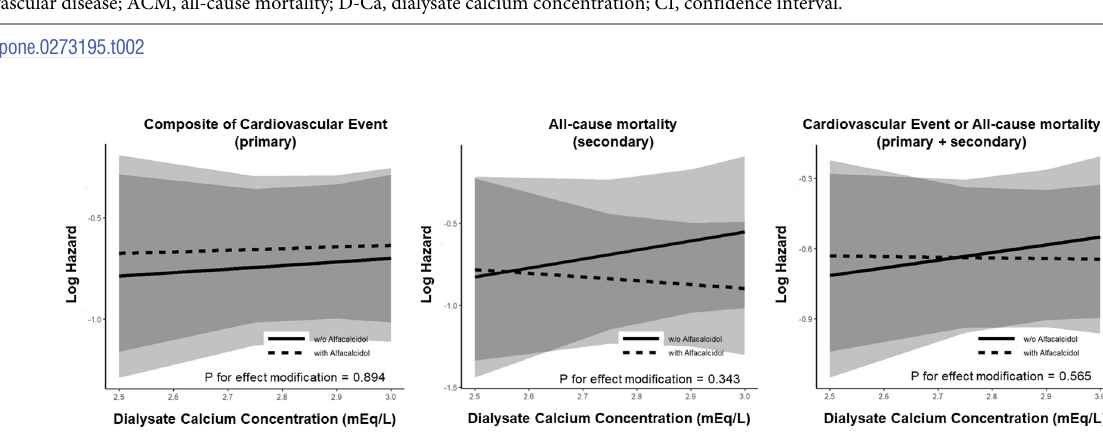
Fig 2. Estimated hazards of composite cardiovascular events (primary outcome), all-cause mortality (secondary outcome), and the combined outcome (primary plus secondary) by the use of alfacalcidol and the baseline dialysate calcium concentration. Estimated hazard was plotted against the dialysate calcium concentration stratified by the use of alfacalcidol.